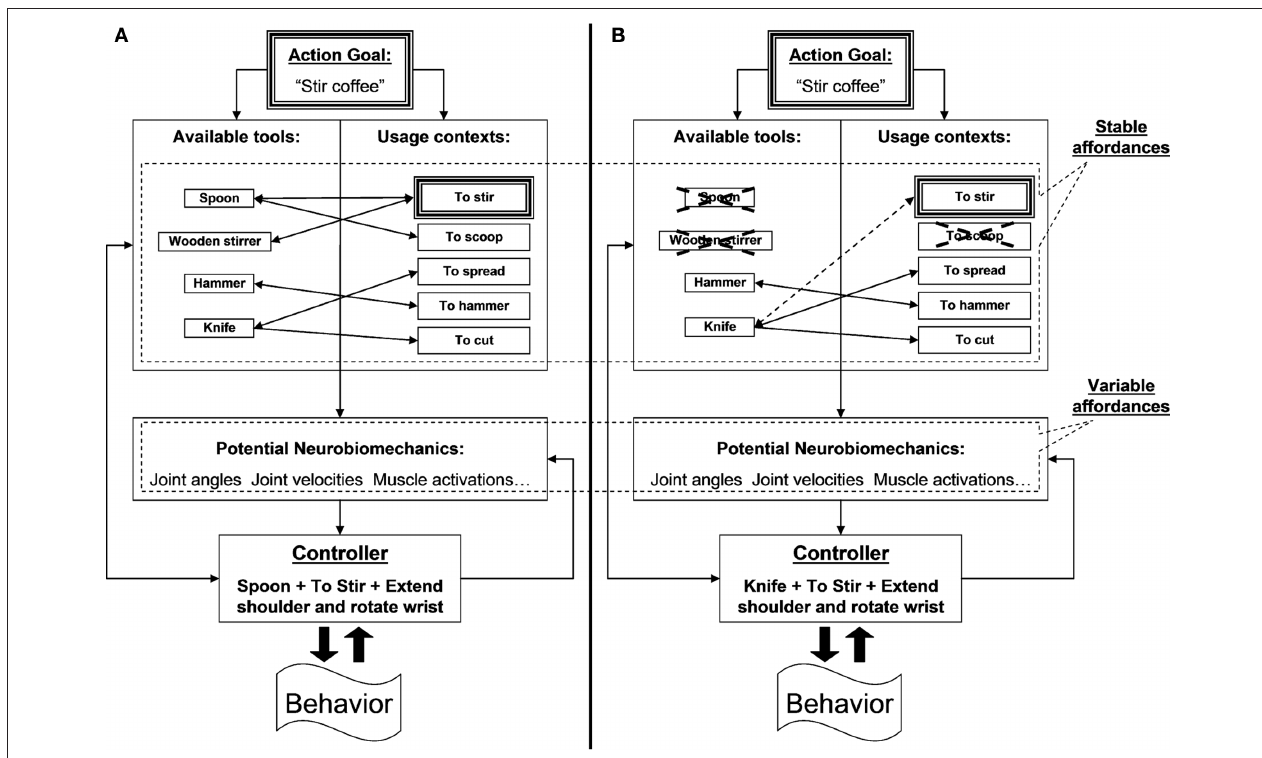
Figure 1 | (A) Selection of the most appropriate tool as a function of the action goal and the automatically activated stable and variable affordances. (B) Selection of an alternative tool which sufficiently matches the features of the unavailable